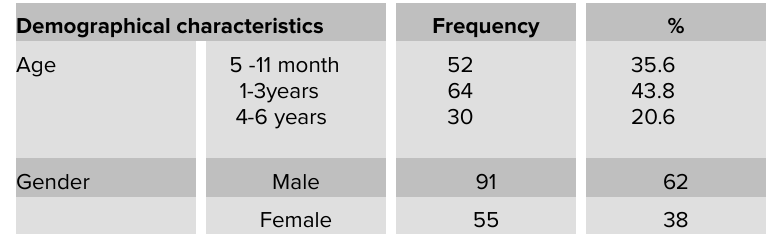
Table 1: Demographic distribution of the study population (n =146).